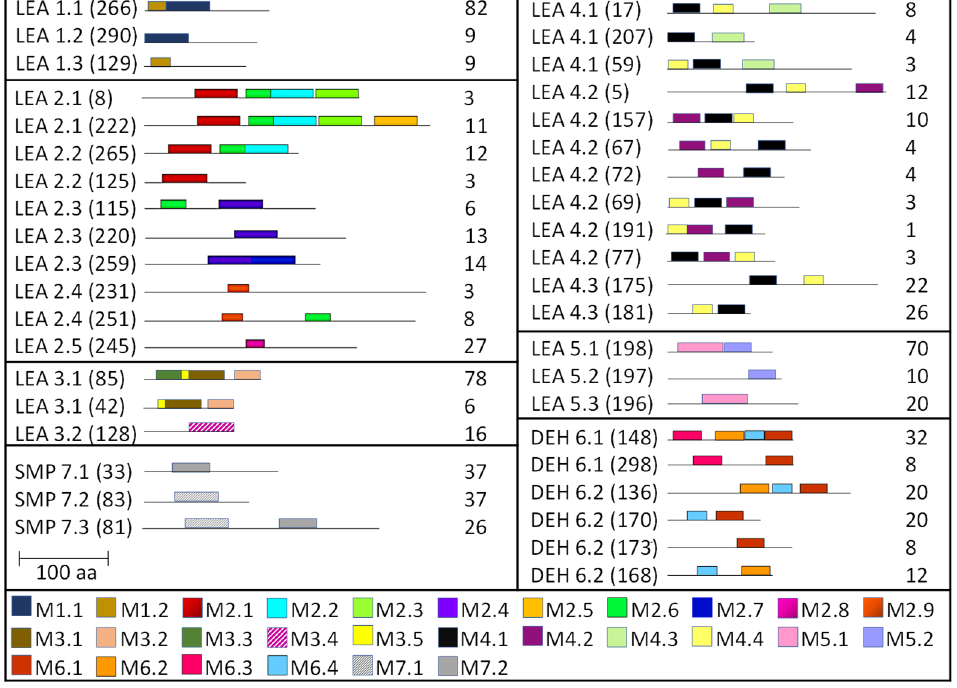
Figure 2. MEME motifs and motif logos of representative LEAPs of each R. serbica LEA protein family group and subgroup. The numbers in the parentheses present the RsLEAP code (see Supplementary Tables S2 and S3). The consensus and logo sequences of each motif are presented in Table 3. The numbers at the end of each protein sequence present a percentage of LEAPs with the same motif pattern in the respective LEA protein family group. The bar represents 100 aa.